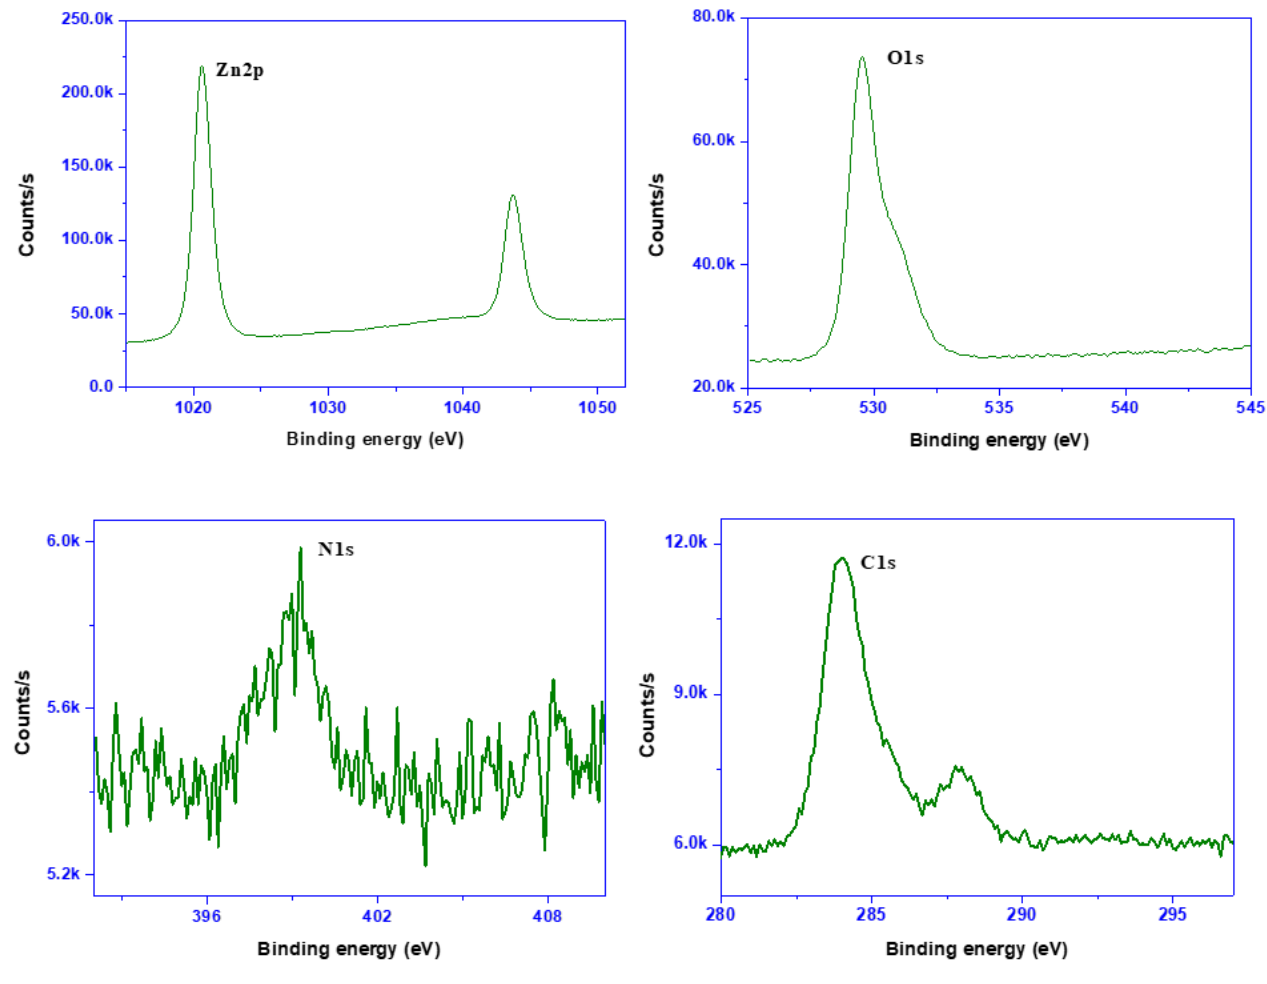
Figure 2. XPS spectra of